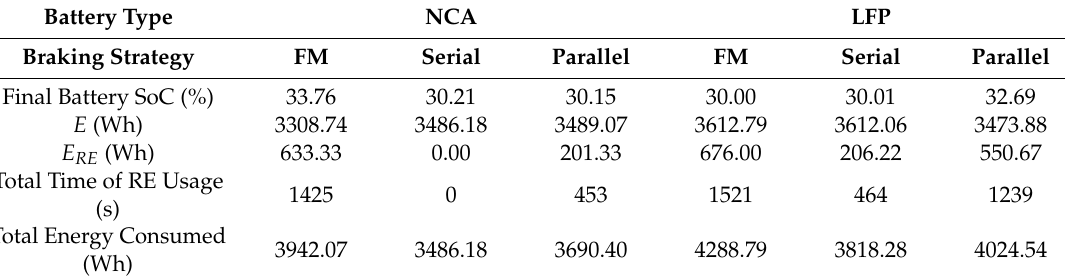
Table 7. Results for the 36.3 kg RE case for the first route.